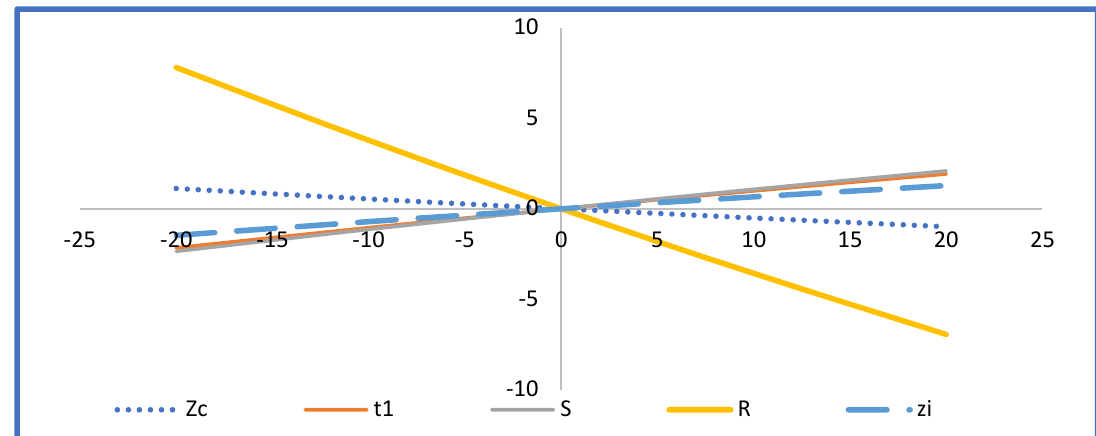
Figure 9. Impact of post optimality analysis of ‘ [ c bL , c bU ] ’ on Z C , t 1 , S , R , and ξ .